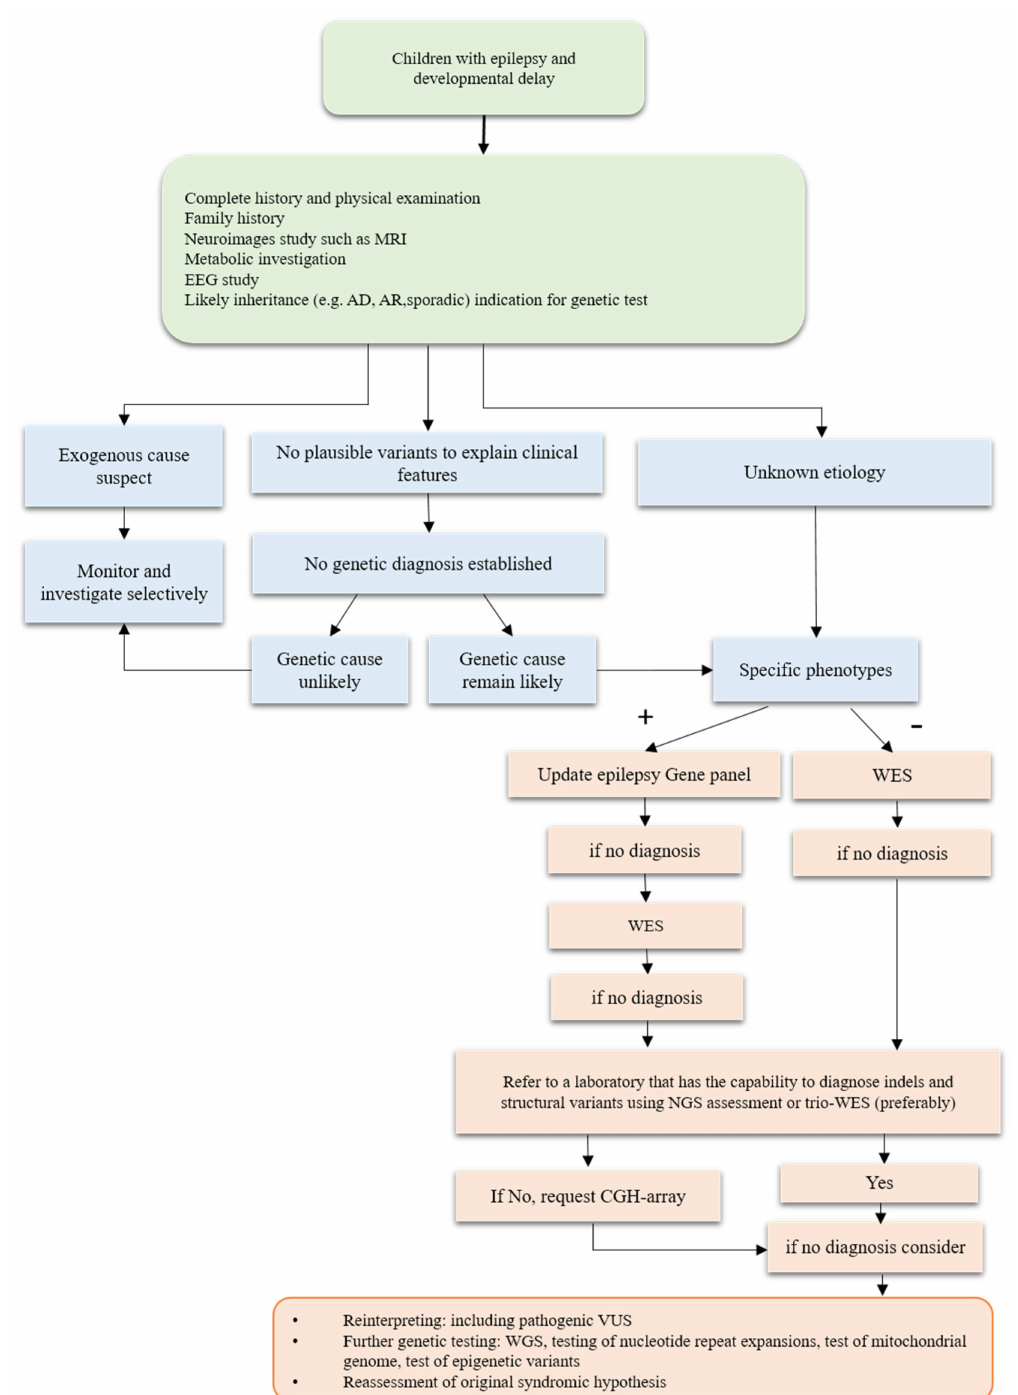
Figure 1. Flowchartillustratingtheinvestigationprocessfordevelopmentalandepilepticencephalopathies. AD, autosomal dominant; AR, autosomal recessive; EEG, electroencephalography; MRI, magnetic reso- nance imaging; VUS, variant of unknown significance; WES, whole-genome